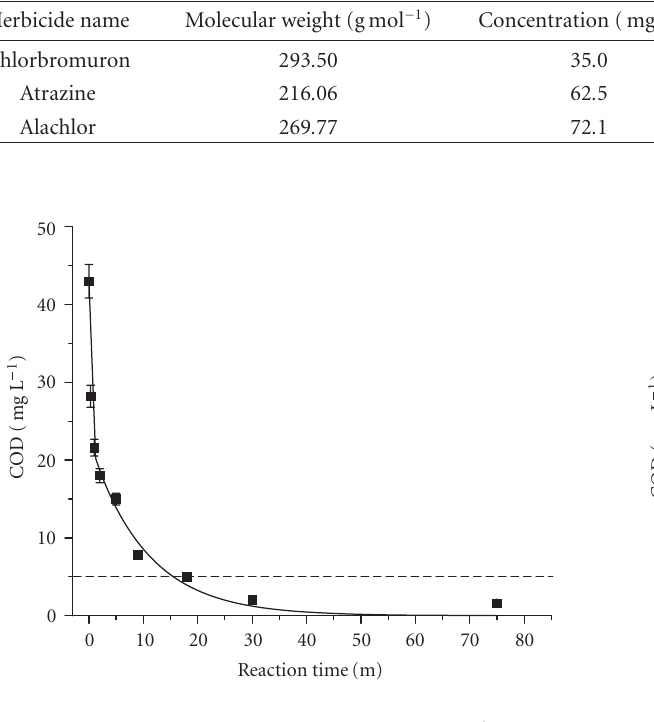
Figure 6: COD abatement of a solution 0 . 289 mmol L − 1 atrazine as a function of solar irradiation time in the presence of TiO 2 . The best fit (—) of the experimental data ( (cid:2) ) was for an exponential decay second-order equation. The dashed line represents the determina- tion limit of COD